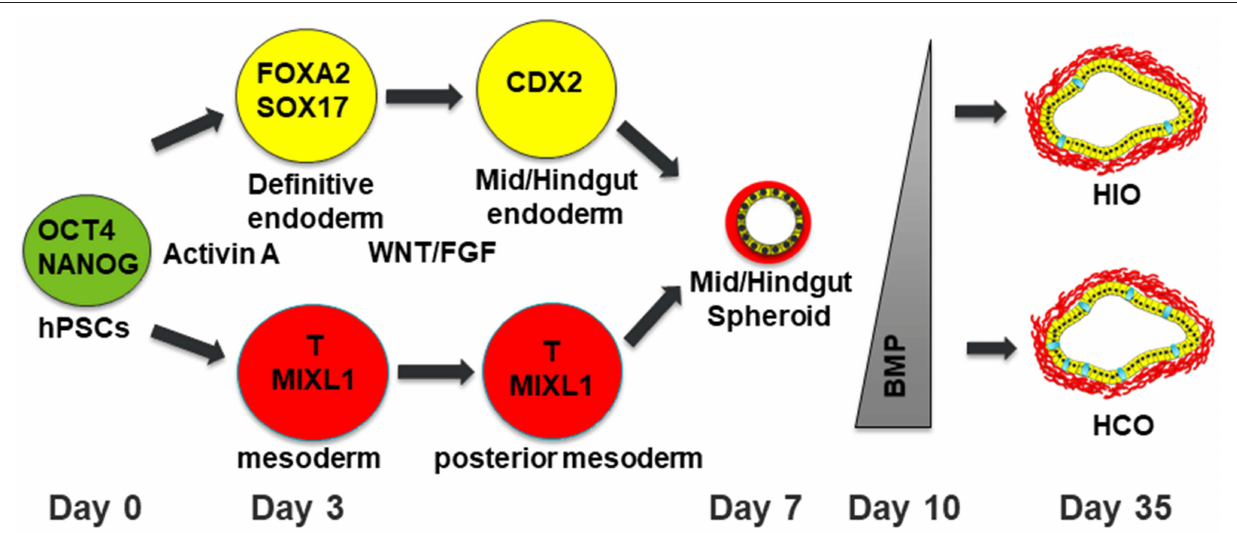
FIGURE 1 | Schematic of differentiation into human intestinal and colonic organoids. Human pluripotent stem cells are differentiated into definitive endoderm (DE) with co-developing mesoderm by treatment with Activin A for 3 days. The resulting DE is then treated with WNT and FGF4 for patterning into mid/hindgut endoderm with posterior mesoderm. After 4 days of treatment with WNT/FGF4, floating spheroids will be evident. These floating spheroids can be plated in a Matrigel bubble and then BMP signaling can either be inhibited for 3 days to generate HIOs or activated for 3 days to generate HCOs with increasing numbers of goblet cells present in HCOs. Human pluripotent stem cells are depicted in green. Definitive endoderm and DE derived cells are depicted in yellow. Mesoderm and mesoderm derived cells are depicted in red. Goblet cells within HIOs and HCOs are depicted in